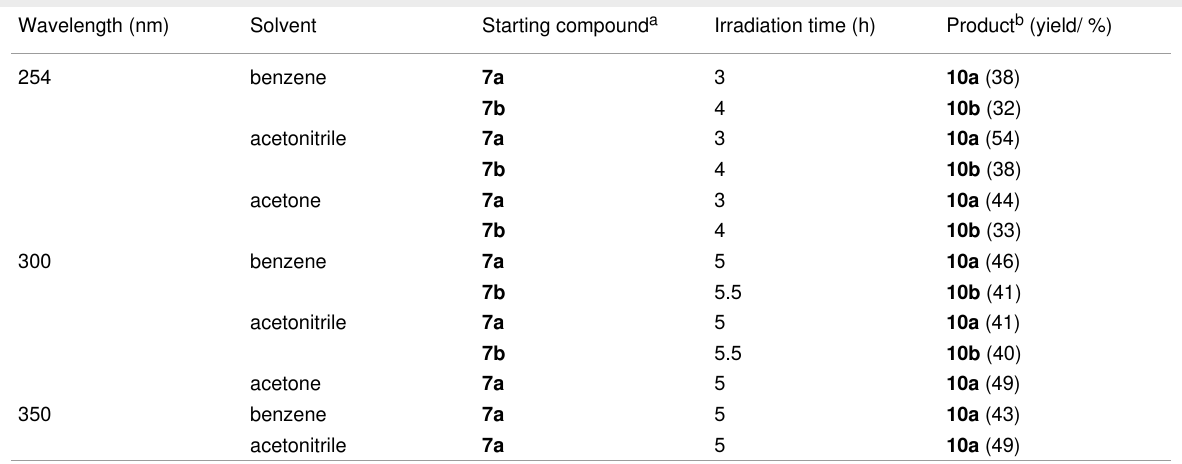
Table 2: Result of photoreaction of 7a , b at various wavelengths in different solvents. Wavelength (nm)